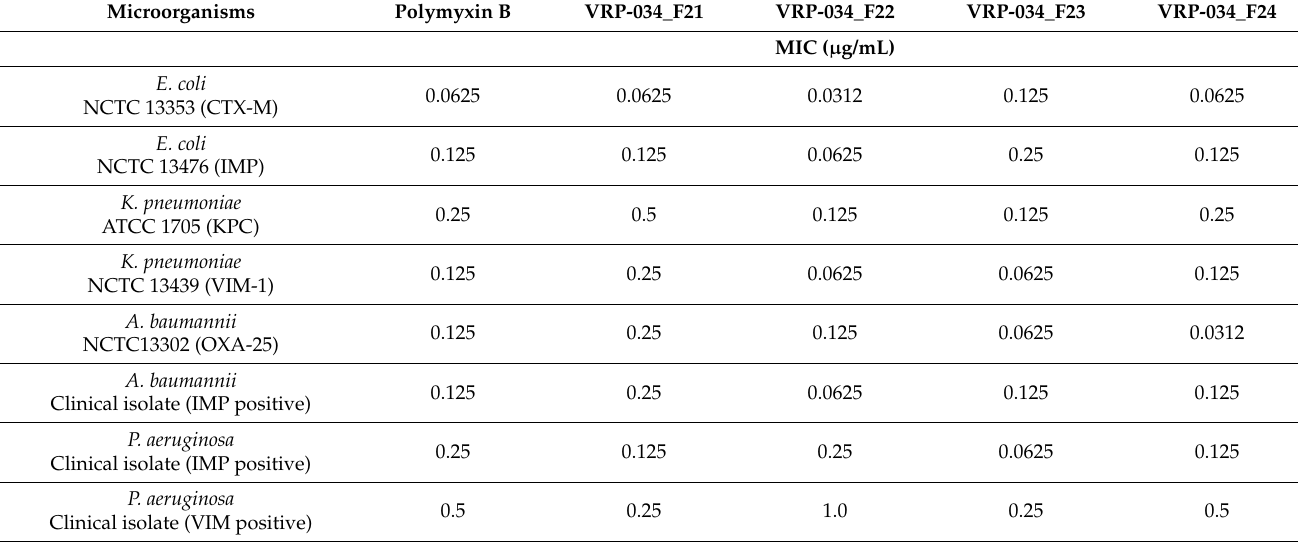
Table A1. Competitive MICs of all the Polymyxin B formulations against gram-negative quality control and clinical isolates.